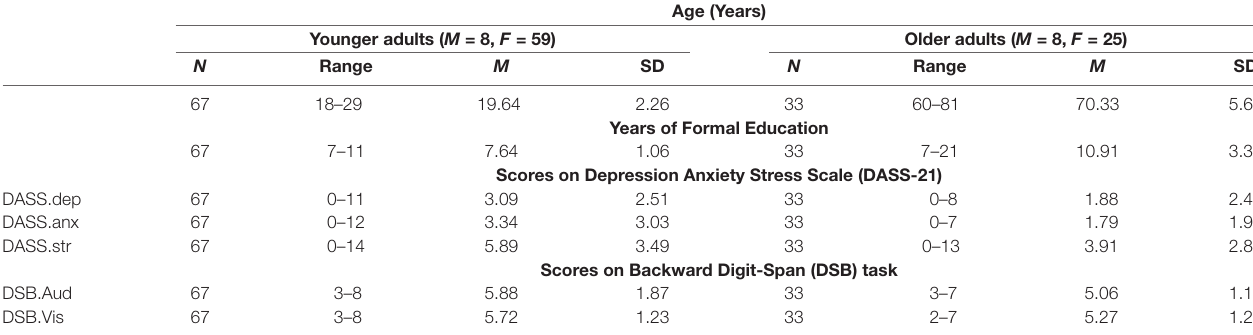
TABLE 1 | Descriptive statistics of age, gender, negative affect (DASS), and backward digit span for young and older adults.